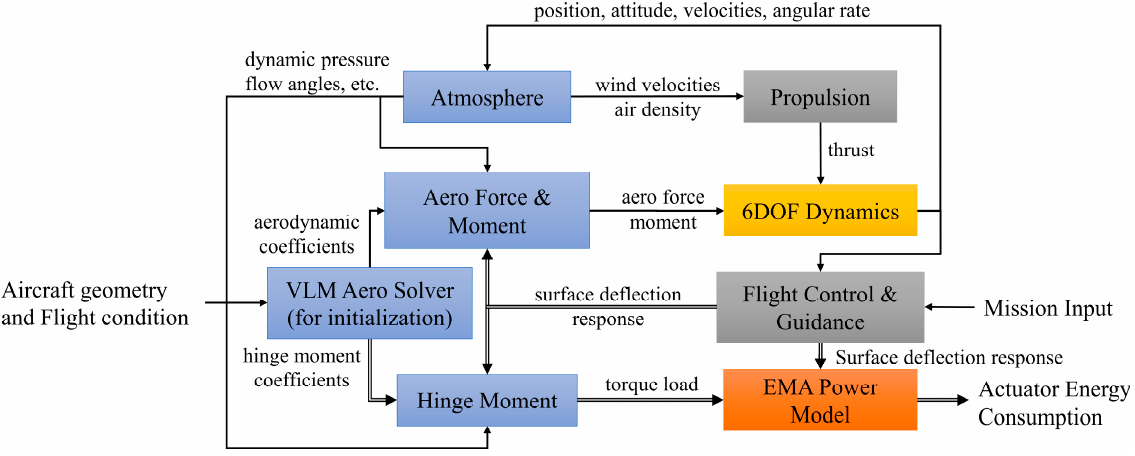
Figure 1. Block diagram representing the simulation framework.